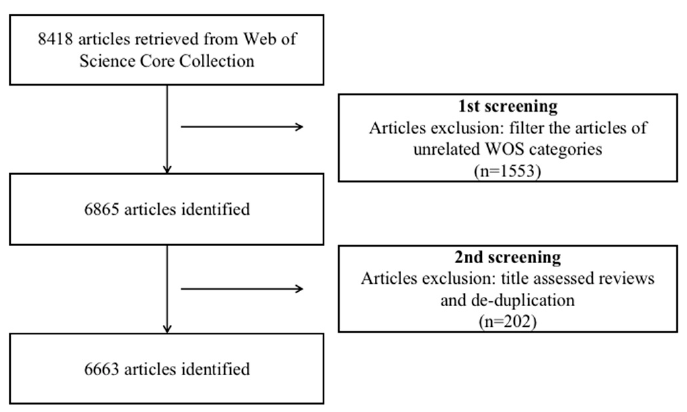
Figure 1. A flowchart representing retrieval strategies for health technology articles from the WOS database and the inclusion criteria for the study.